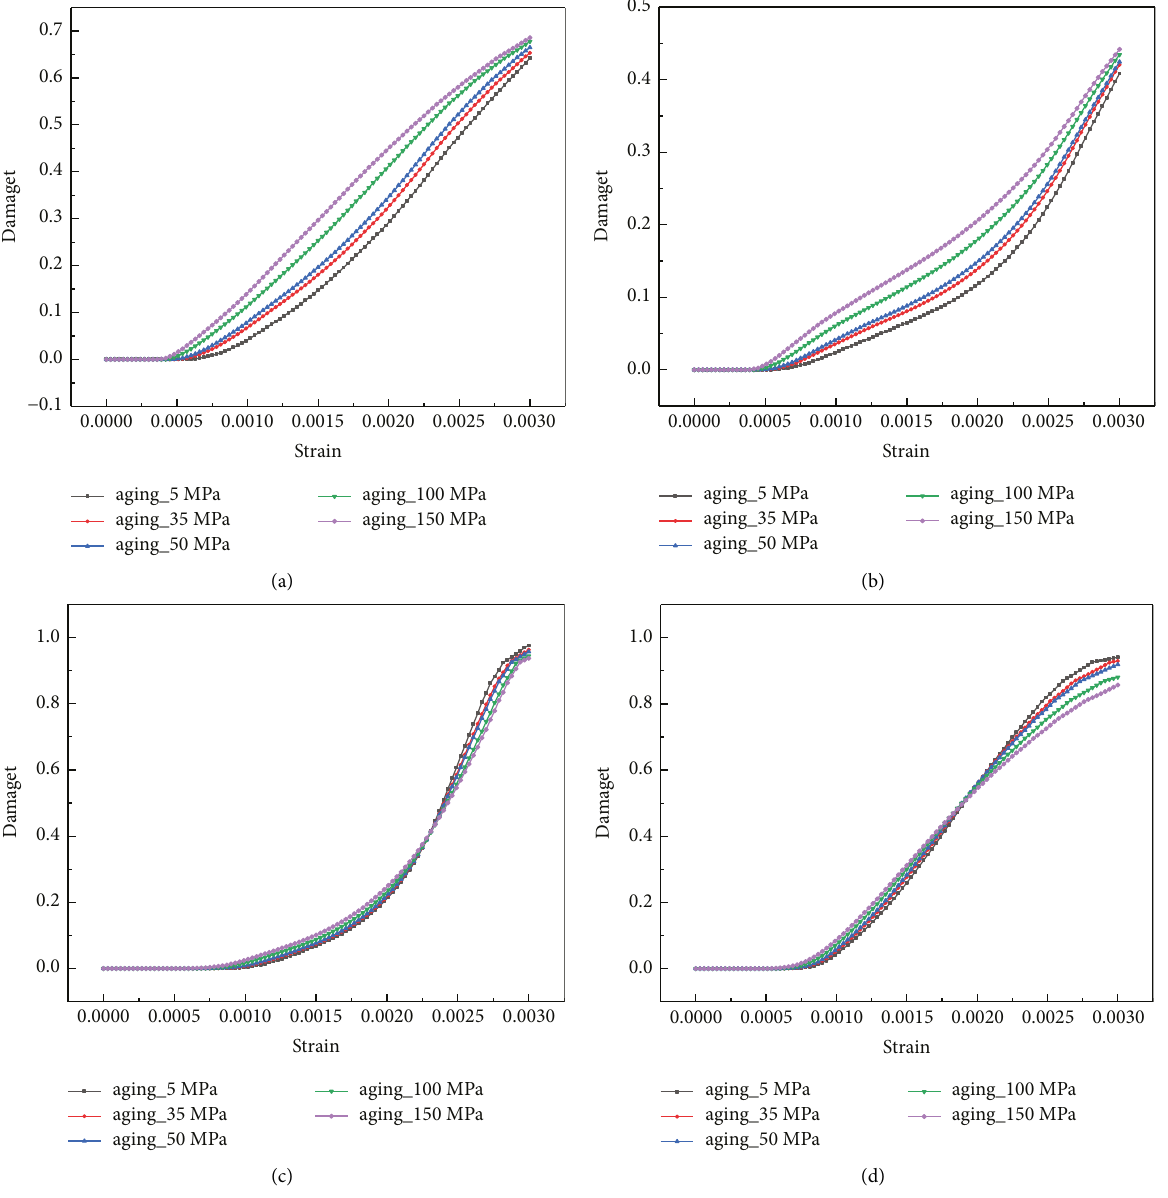
Figure 8: Variation curve of tensile damage factor with strain of selected mortar unit. (a) #1 mortar unit, (b) #2 mortar unit, (c) #3 mortar unit, (d) #4 mortar